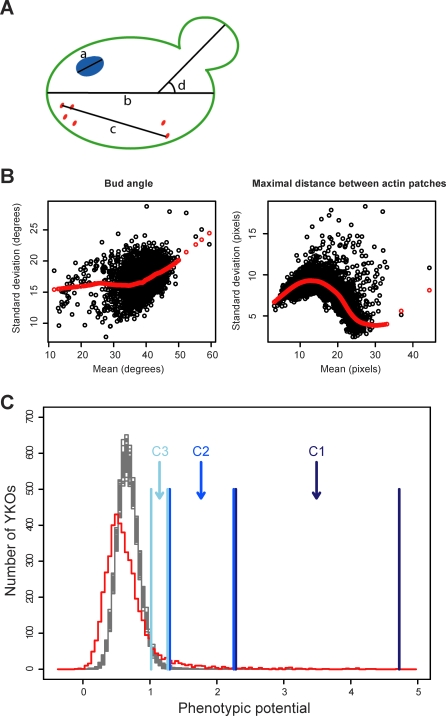
Genome-Wide Screen for Phenotypic Capacitors in S. cerevisiae
(A) Schematic of some quantitative phenotypes in a budded cell: (a) long axis length of the mother nucleus, (b) long axis length in the mother cell, (c) maximal distance between actin patches, (d) bud angle. A full list of phenotypes and their descriptions is reported in Ohya et al. [17].(B) Scatter plots of means and standard deviations for 4,718 YKO strains for two phenotypes clearly indicate that variance depends on mean in a nontrivial, phenotype-specific manner. Black circles represent individual YKOs and red circles represent the lowess curve fit.(C) Histograms of actual (red) and 100 randomized (grey) phenotypic potential scores. Shown are the ranges of the three phenotypic capacitor classes (C1, C2, C3).